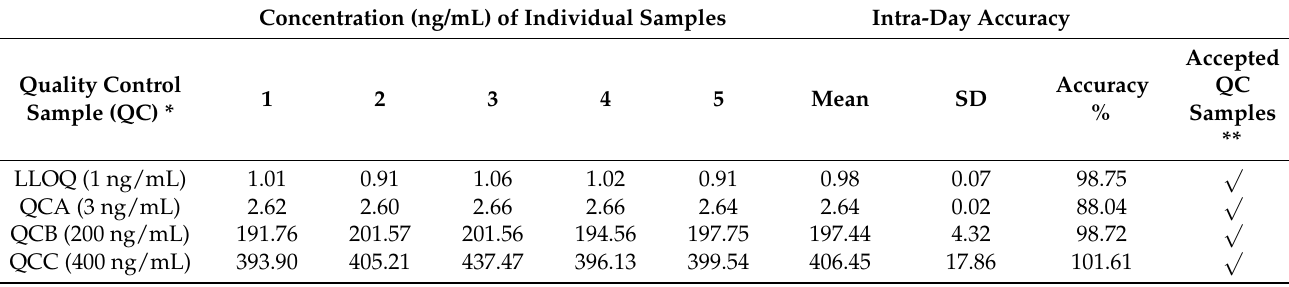
Table 2. Intra-day accuracy validation data for the method of quantitation of sildenafil in human plasma samples by liquid chromatography-tandem mass spectrometry.